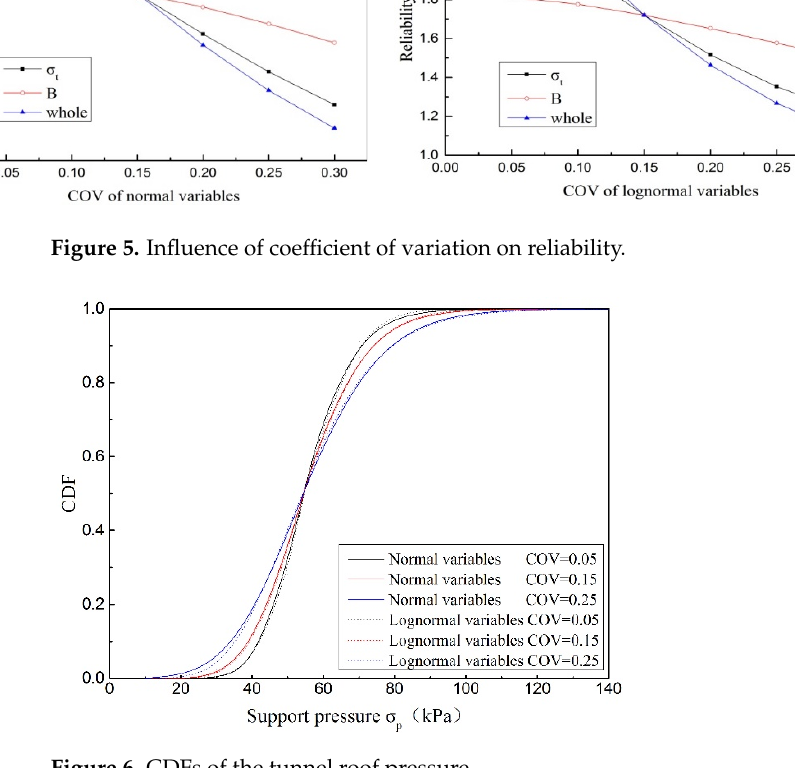
Figure 6. CDFs of the tunnel roof pressure.